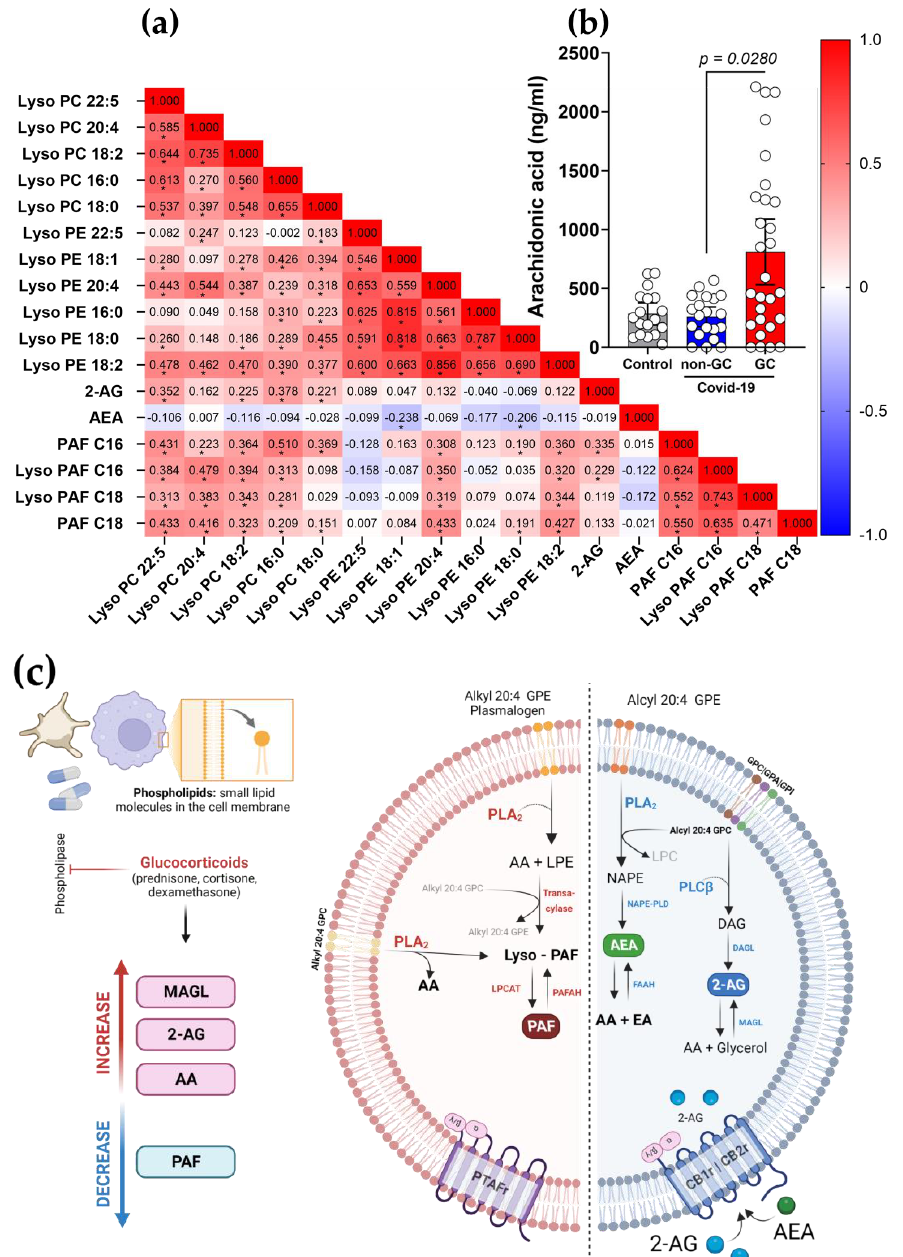
Figure 5. Altered profile of eCBs and PAF induced by the use of GCs in patients with COVID-19. ( a ) Correlation matrix between lipid mediators species in individuals using GCs. The color scale sidebar indicates the correlation coefficients ( r ), color-coded: red, positive correlation; blue, negative correlation; the intensity of the color represents the intensity of the correlation. Values adjust between − 1.0 and 1.0. Significance levels indicated with gray asterisks are based on the p -value < 0.05 of the Spearman’s correlation coefficient ( r )*. ( b ) Production of arachidonic acid (AA) in COVID-19 patients with the use of GCs, healthy controls ( n = 18), non-GC ( n = 22) and GC ( n = 30). Statistical analyses were performed using the Kruskal–Wallis multiple comparison test (non-parametric), followed by Dunn’s post-test. Data are expressed as median in boxplot graphs with minimum and maximum values with a confidence interval of +/ − 95%. Significance levels shown are based on statistically significant p < 0.05 values between groups. ( c ) Schematic representation of the eCBs and PAF path- ways in COVID-19 patients and the regulation of GCs in this model. (Created with BioRender.com, Agreement number: